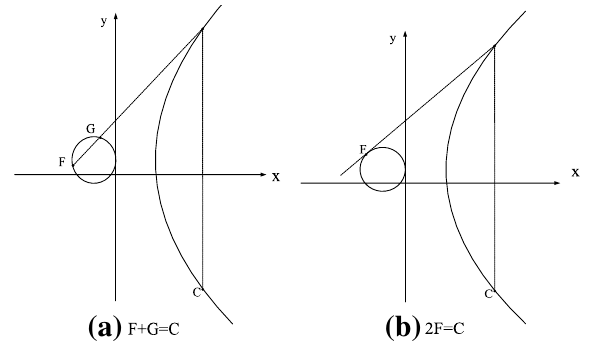
Fig. 4 Addition and multiplication on elliptic curves